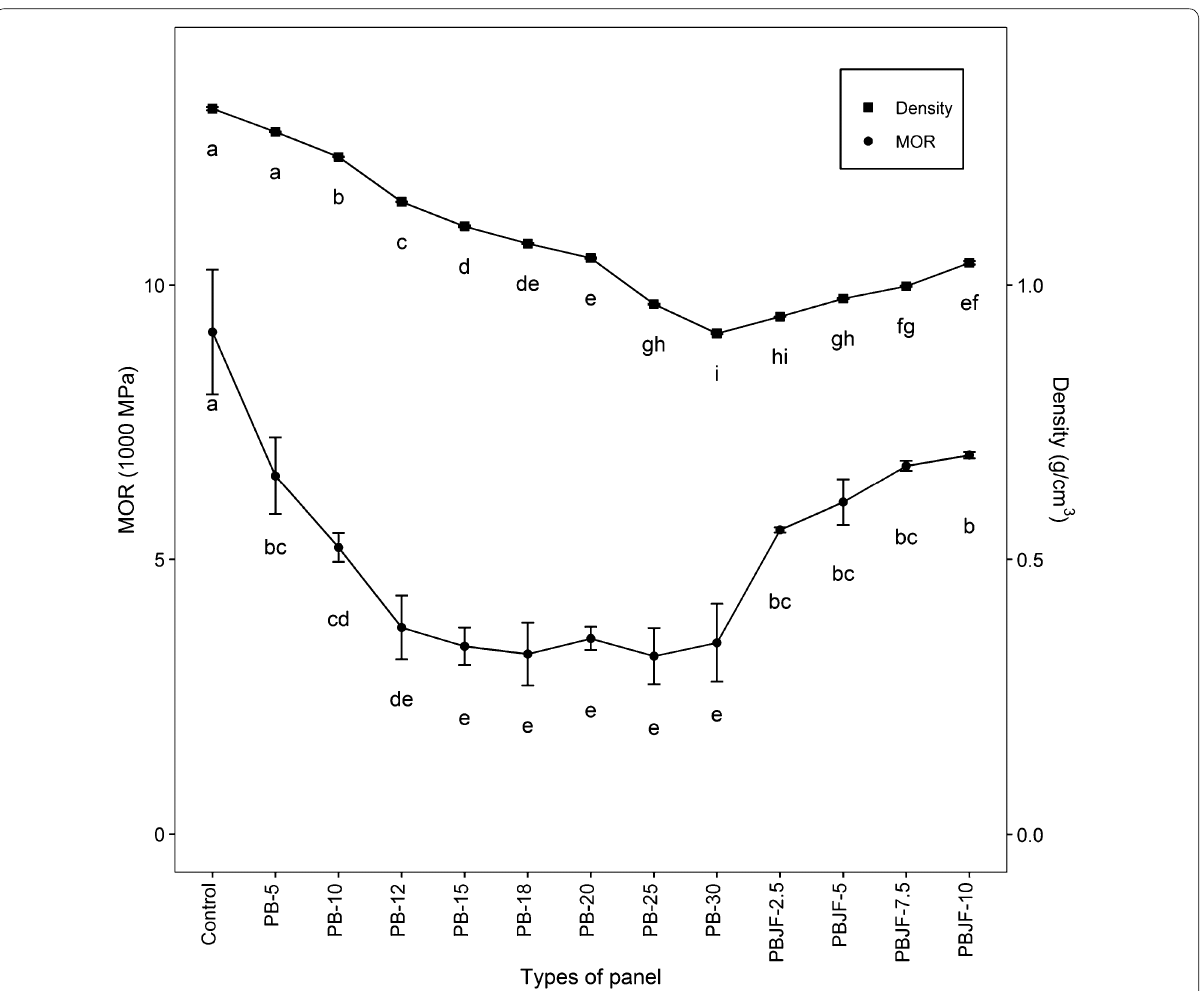
Fig. 5 Modulus of rupture and density variation for different types of CBCs. Different letters below each point indicate statistically significant differences among groups ( p <